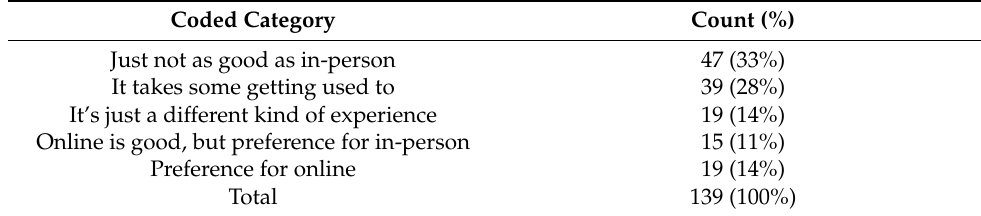
Table 4. Perceptions of In-Person Versus Remote Play. Coded Category Count (%) Just not as good as in-person 47